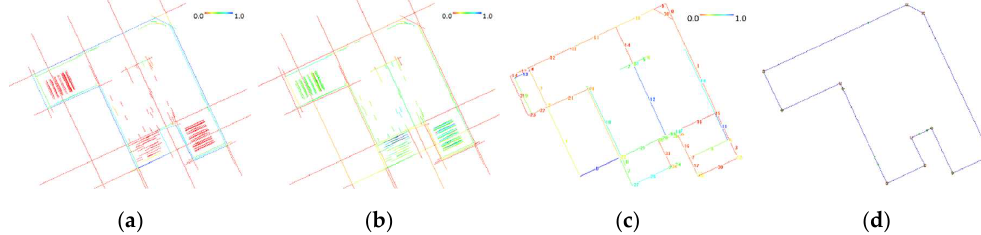
Figure 7. An illustration of the data term and the selection strategy. ( a ) Candidates rendered by the value of the distribution. ( b ) Candidates rendered by the value of sharpness. ( c ) Candidates rendered by the value of the data term. Candidates whose endpoint is 1-link or too close to other candidates are excluded from data term calculation. ( d ) Optimization result.